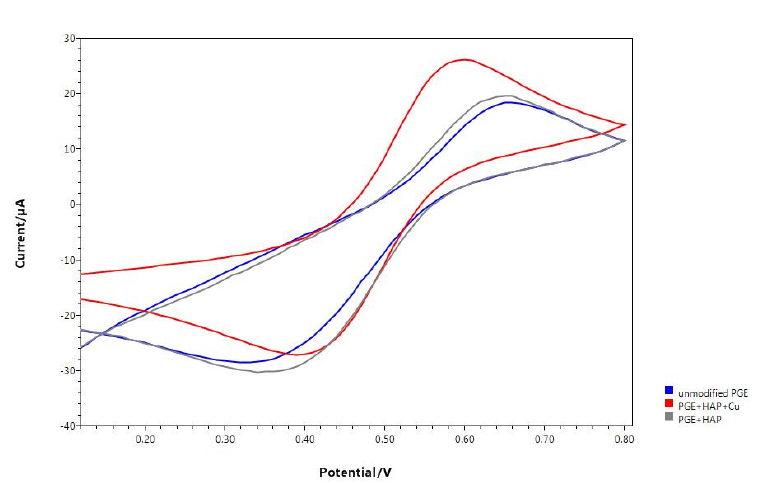
Figure 4. cyclic voltammograms of unmodified and modified PGE with HAP and CuO in 2.0 mM Figure 4. Cyclic voltammograms of unmodified and modified PGE with HAP and CuO in 2.0 mM FeCl 3 in 1.0 M HCl with a scan rate of 10 mV s − 1 . FeCl 3 in 1.0 M HCl with a scan rate of 10 mV s − 1